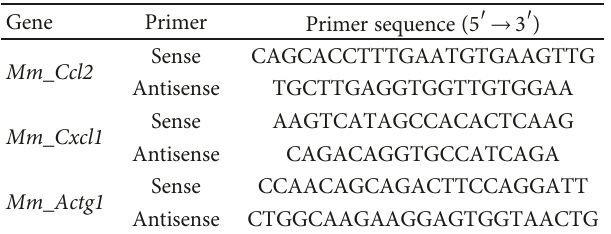
Table 1: Primers used for detection of proin fl ammatory mediator expression in murine